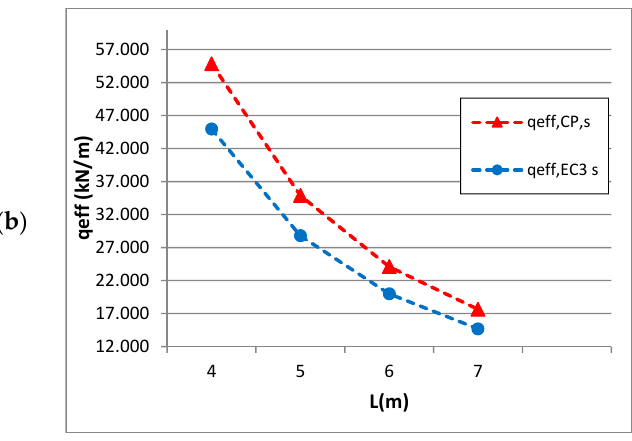
Figure 12. Graphs of ( a ) q cr , s and ( b ) q ef f as a function of length L